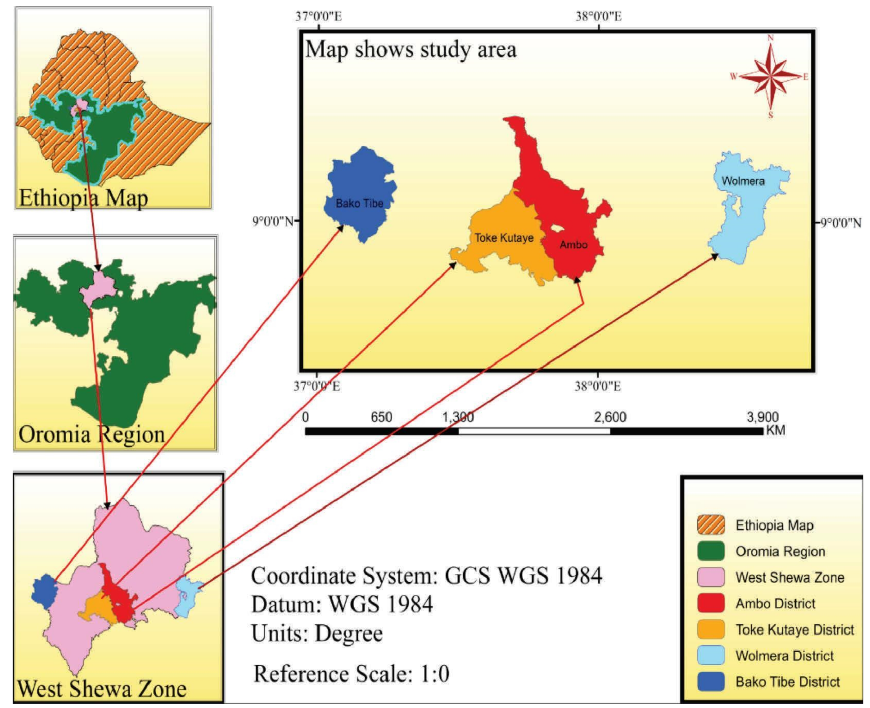
Figure 1: Map of the study area. Table 1: General characteristics and agroecological features of the selected